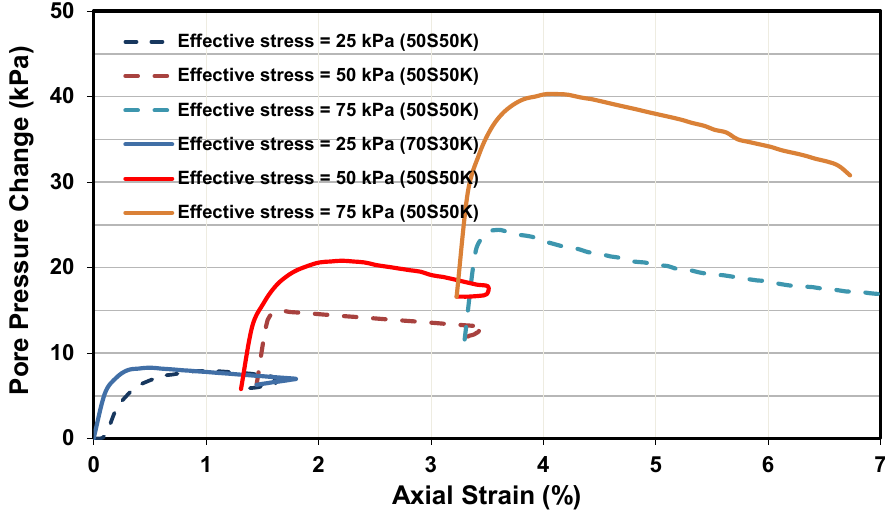
Figure 9. Pore-water pressure changes against axial strain of soil specimen 70S30K and 50S50K from saturated shear strength.